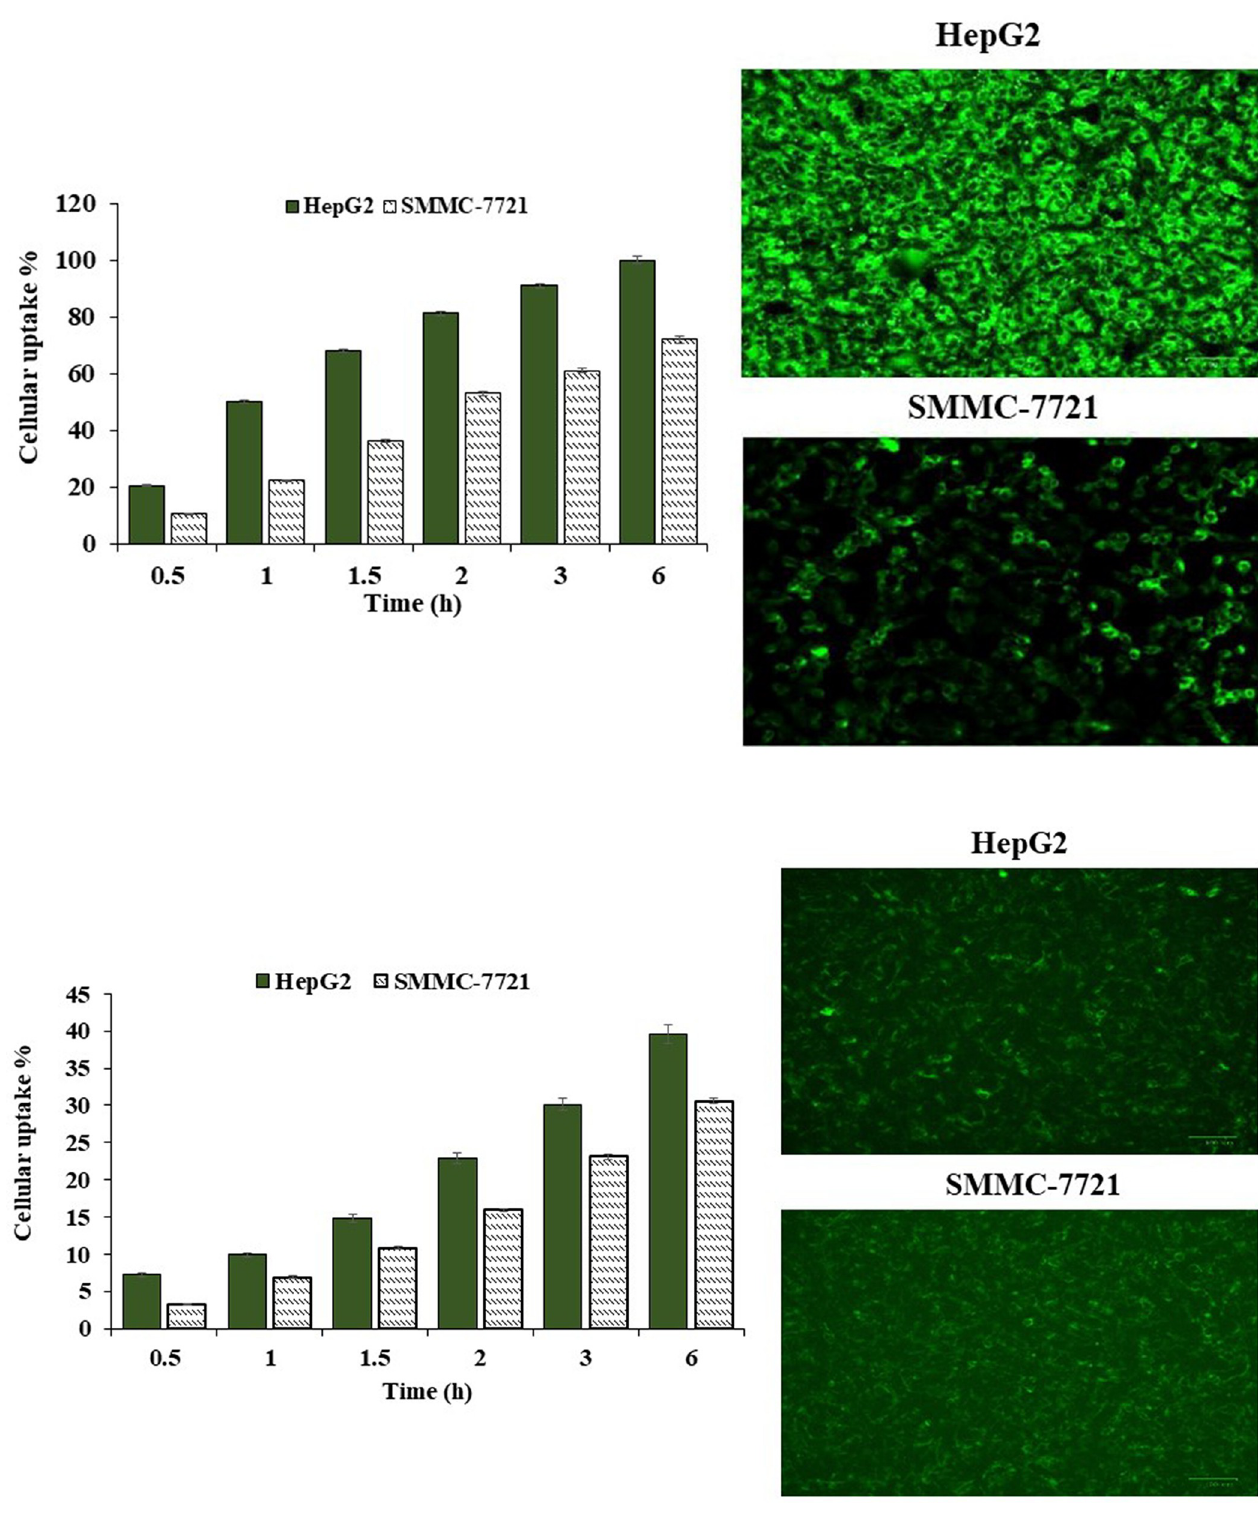
Fig 5. Cellular uptake of bee venom-loaded CSNPs. ( A ) Cellular uptake of coumarin-6-loaded targeted bee venom nanoparticles in HepG2 and SMMC-7721 cells; ( B ) coumarin-6-loaded non-targeted nanoparticles in HepG2 and SMMC-7721 cells, n = 3.